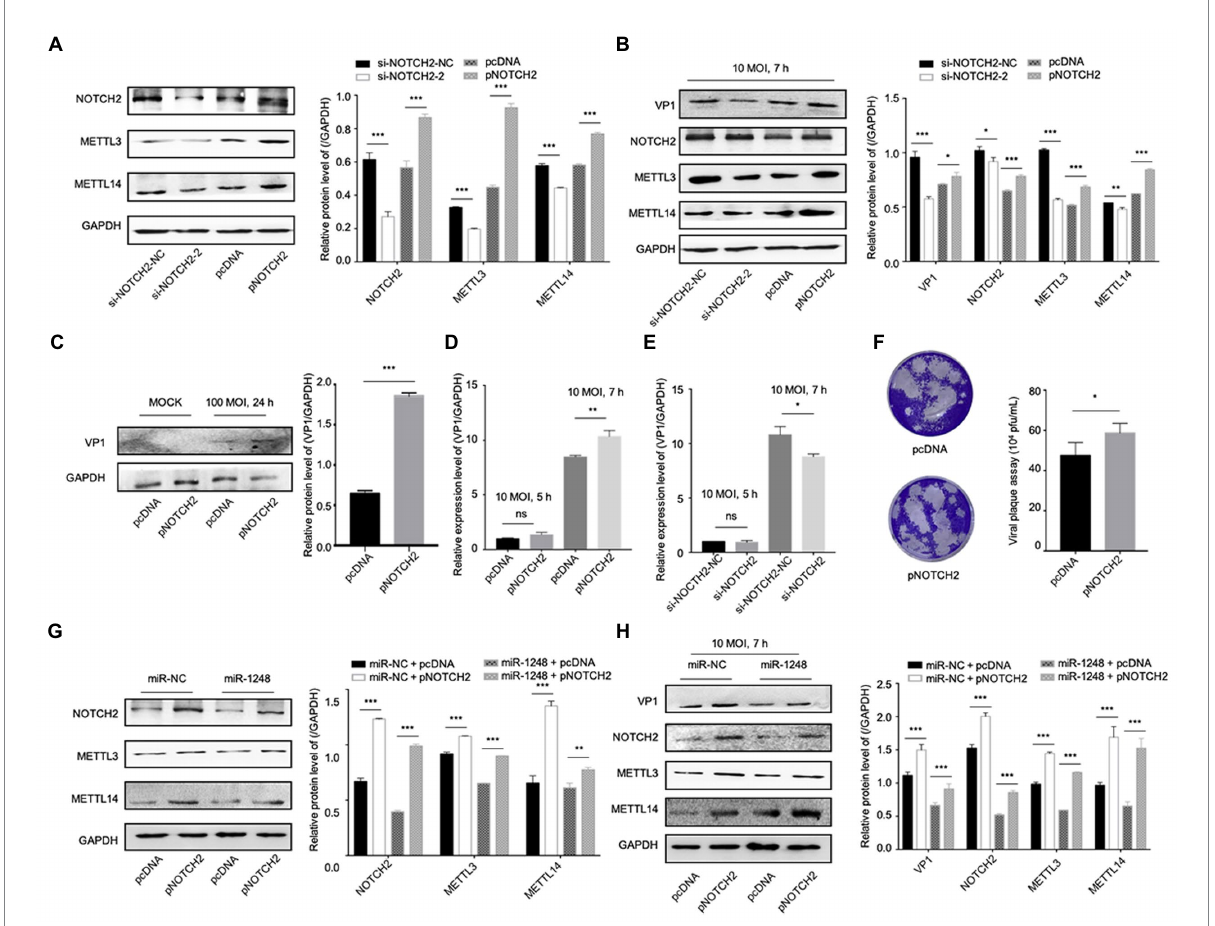
FIGURE 6 MiR-1248 regulates CVB3 replication by targeting NOTCH2 through methylation-related pathways. (A) HeLa cells transfected with pNOTCH2 or pcDNA, detected by Western blot. (B) HeLa cells transfected with pNOTCH2 or pcDNA and infected CVB3 (10 MOI) for 7 h, detected by Western blot. (C) HL-1 cells transfected the pNOTCH2, infected CVB3 (100 MOI) for 24 h, and Western blot analyzed the VP1. (D,E) HeLa cells transfected pNOTCH2 or si-NOTCH2-2, infected CVB3 (10 MOI) for 7 h, and RT-qPCR to detect the VP1 expression. (F) Viral titers were determined by plaque assay using the supernatants ( n = 3). (G) HeLa cells co-transfected miR-1248 and pNOTCH2, Western blot to analyze the signals. (H) HeLa cells co-transfected miR-1248 and pNOTCH2, cells infected CVB3 (10 MOI) for 7 h, indicated signals were detected by Western blot. * p < 0.05, ** p < 0.01, *** p <